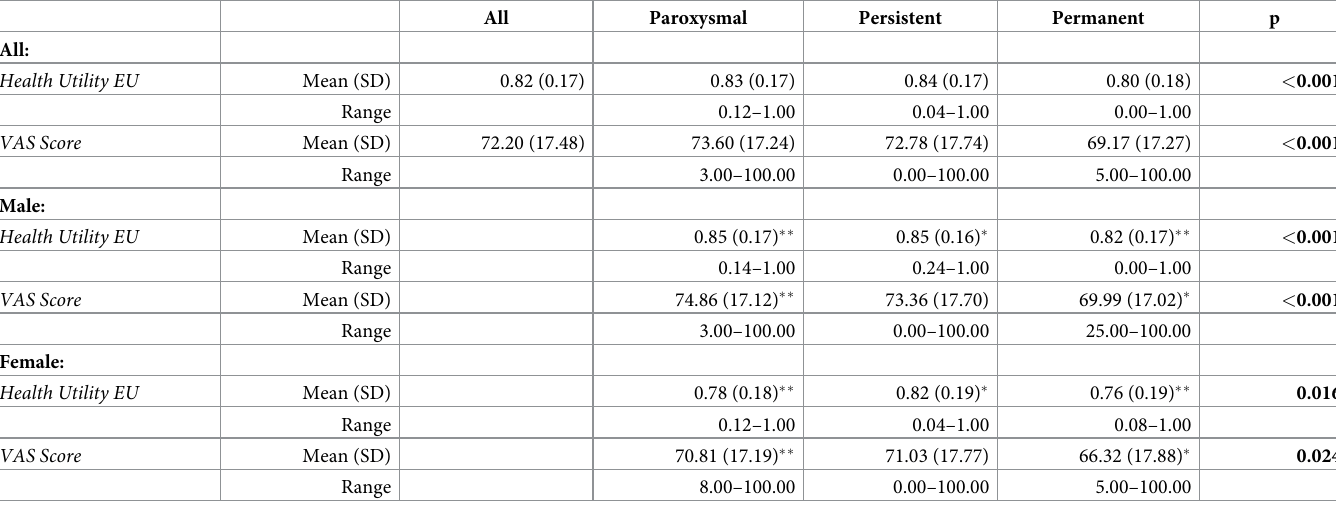
Table 3. EQ-5D-EU-Utilities and VAS Scores according to AF type. All Paroxysmal Persistent Permanent